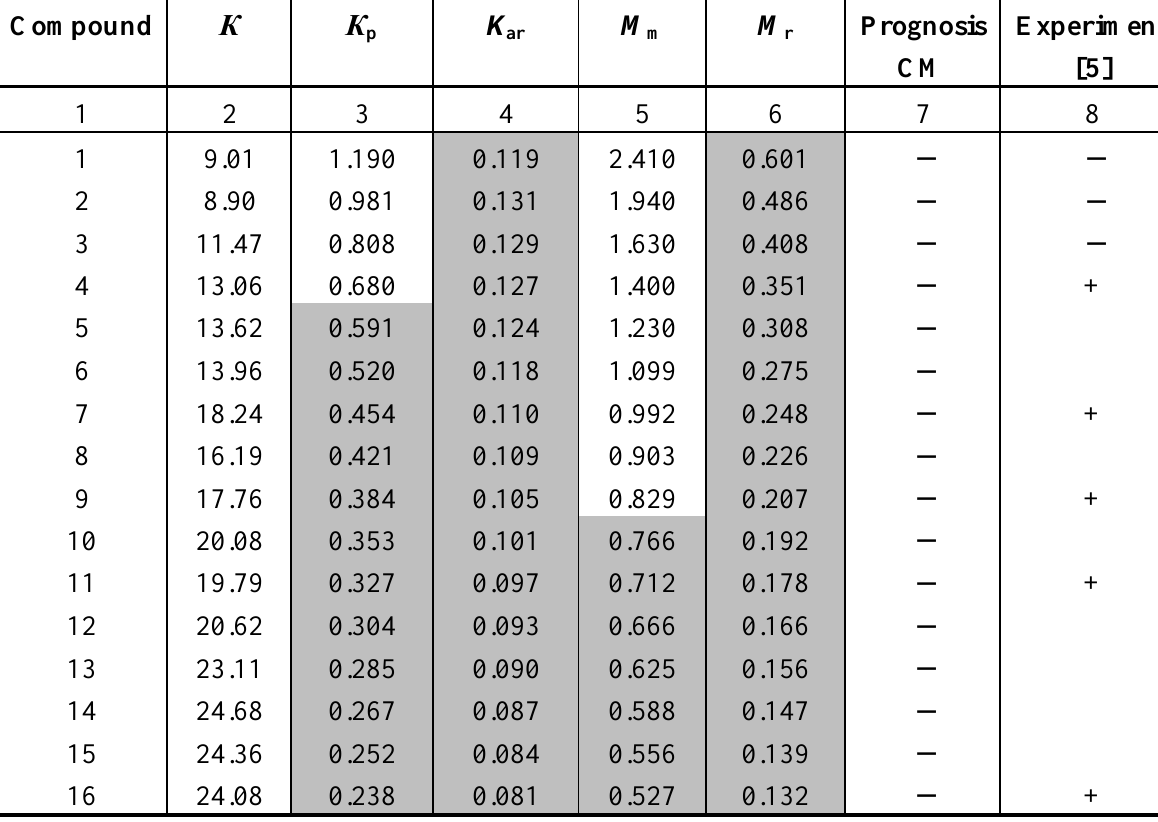
Table 1. Calculated values of molecular parameters of known and hypothetical structures of